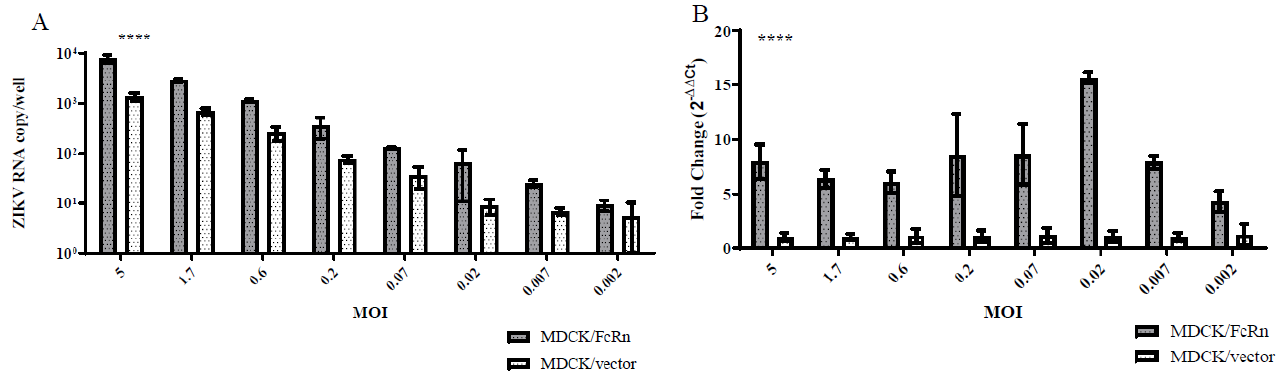
Figure 1. Marvin Darby Canine Kidney (MDCK) cells that overexpress human FcRn are more permissive of Zika virus (ZIKV) infection than those that do not. MDCK/FcRn (shaded bars) or MDCK/vector cells were infected with serial dilutions of ZIKV, and cellular ZIKV RNA expression at 48 h was quantified using either ( A ) a standard curve, or ( B ) an endogenous gene expression (canine GAPDH). The experiment was performed in quadruplicates for each of the 8 dilutions and data was analyzed using a two-tailed paired t test, comparing infection levels in the two cell lines at each MOI level, respectively, **** p < 0.0001.